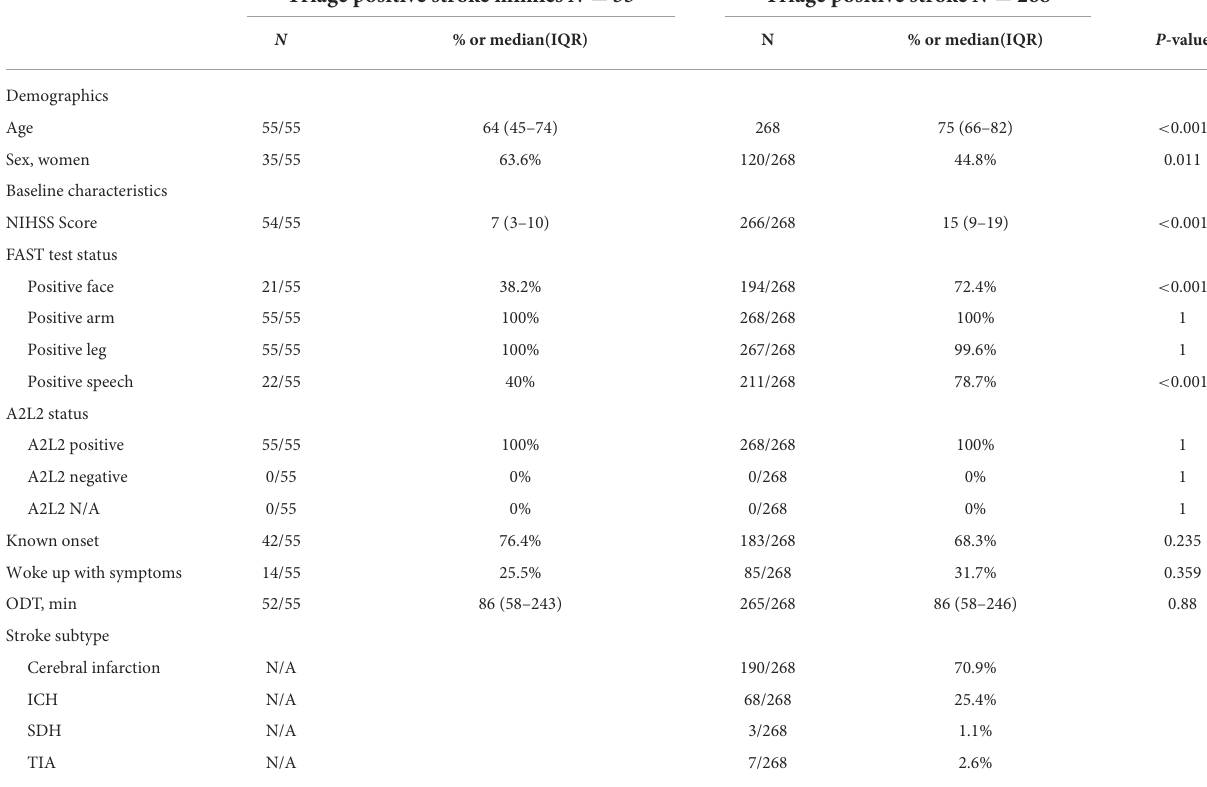
TABLE 1 Comparison of triage-positive stroke mimics vs. triage-positive stroke. Triage positive stroke mimics N =